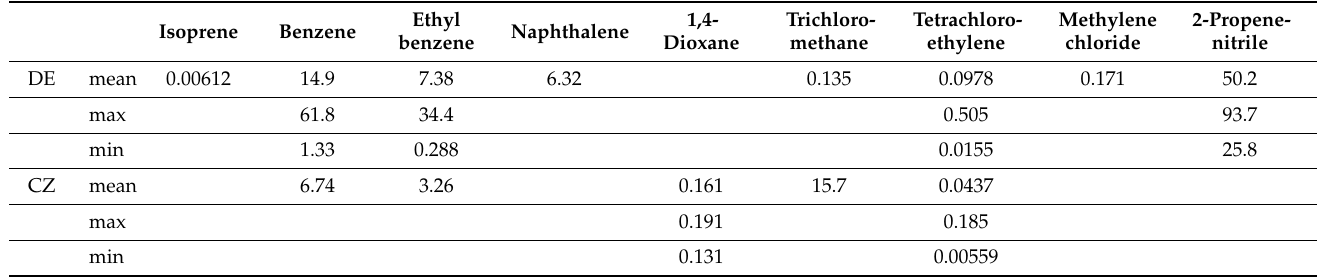
Table 10. Estimated individual lifetime cancer risk ( × 10 6 ) of chemical substances sampled